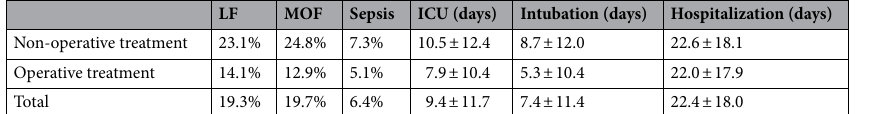
LF MOF Sepsis ICU (days) Intubation (days) Hospitalization (days)